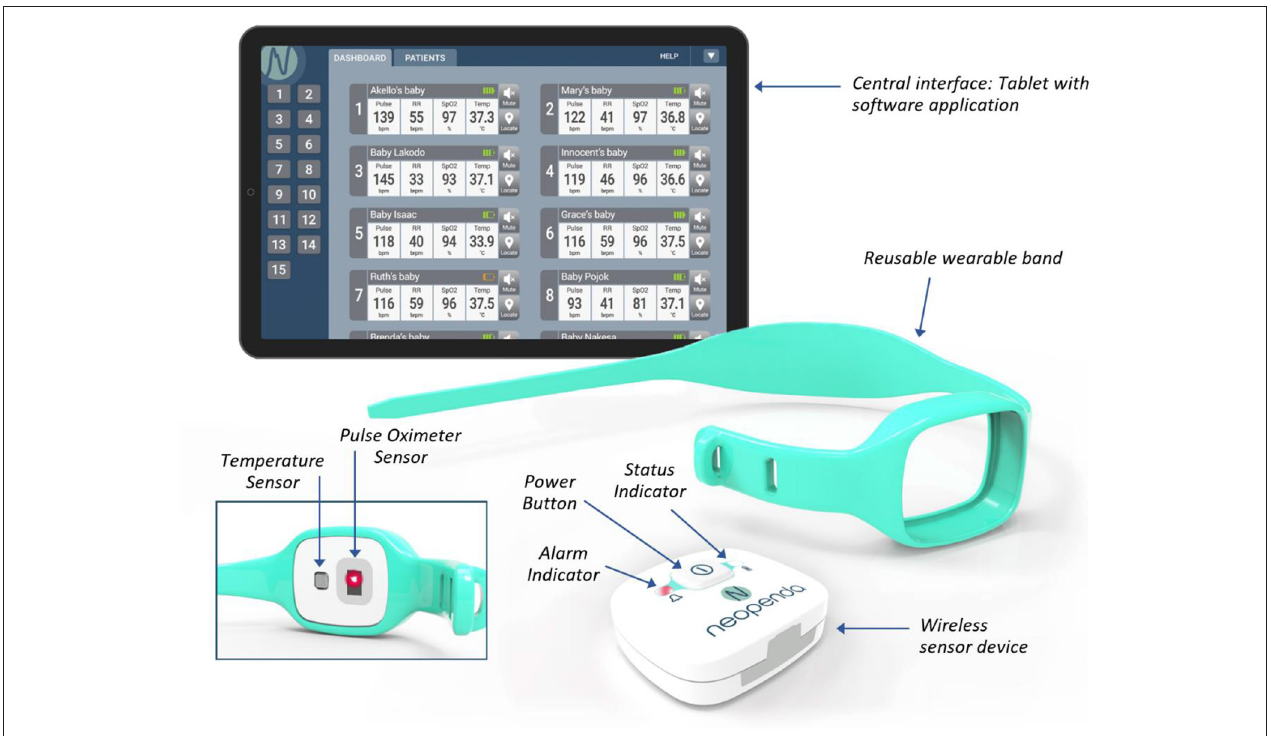
FIGURE 1 | The neoGuard V1.0 vital signs monitoring